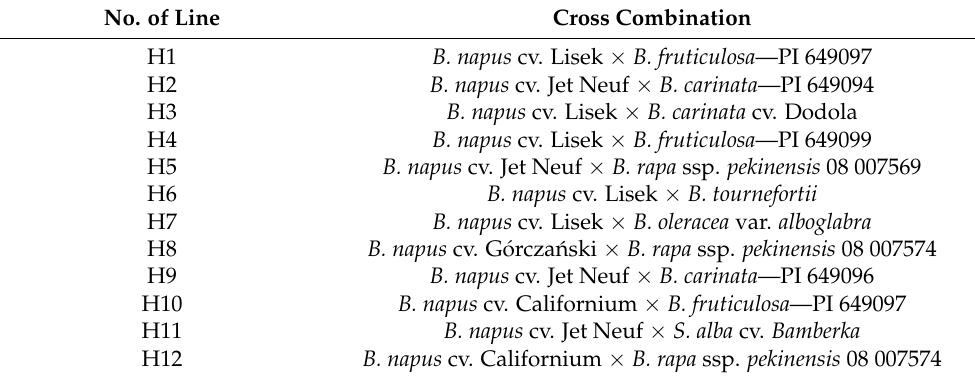
Table 1. List of hybrid genotypes used in the